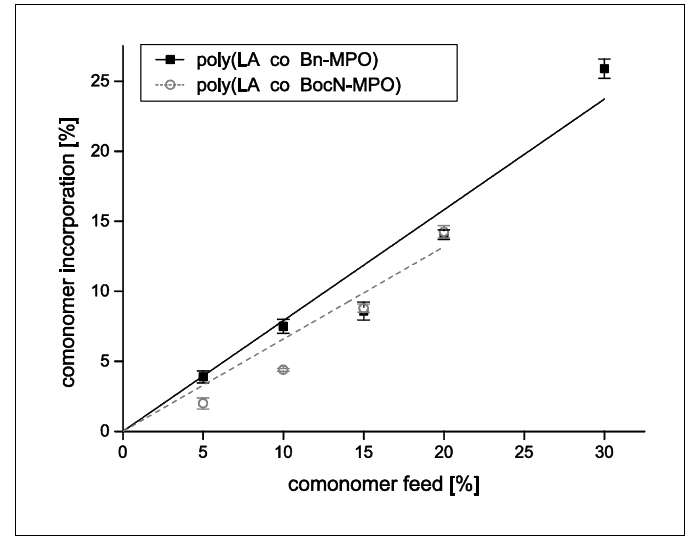
Figure 6. Incorporation efficiency of Bn-MPO and BocN-MPO into copolymers with